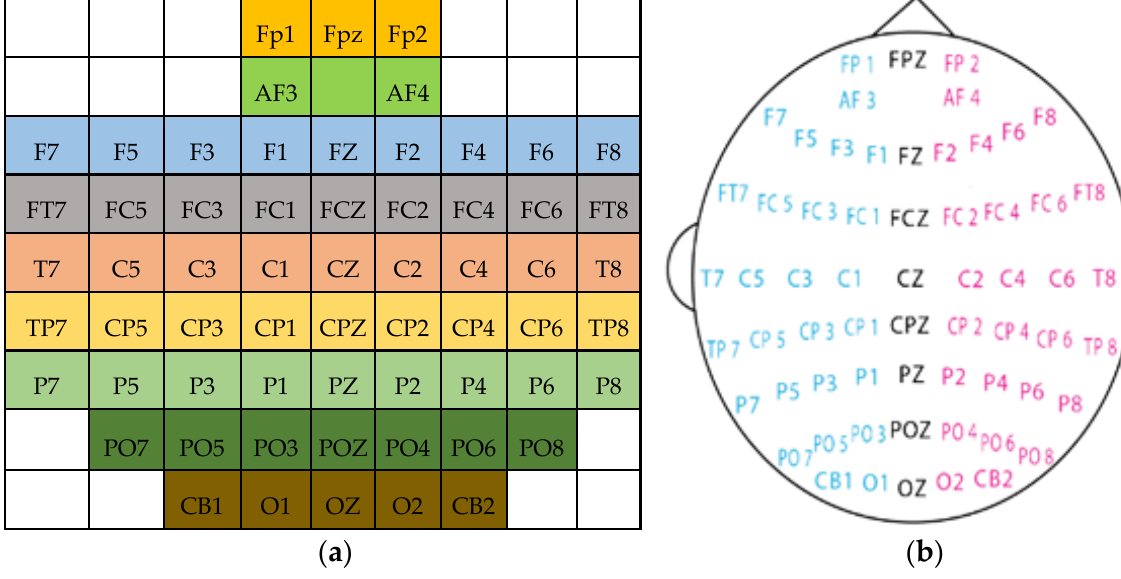
Figure 1. ( a ) EEG electrode arrangements on 2D 9 × 9 frame; ( b ) Electrode placement in SEED and SEED-IV datasets. Schemes follow another format [29–31].